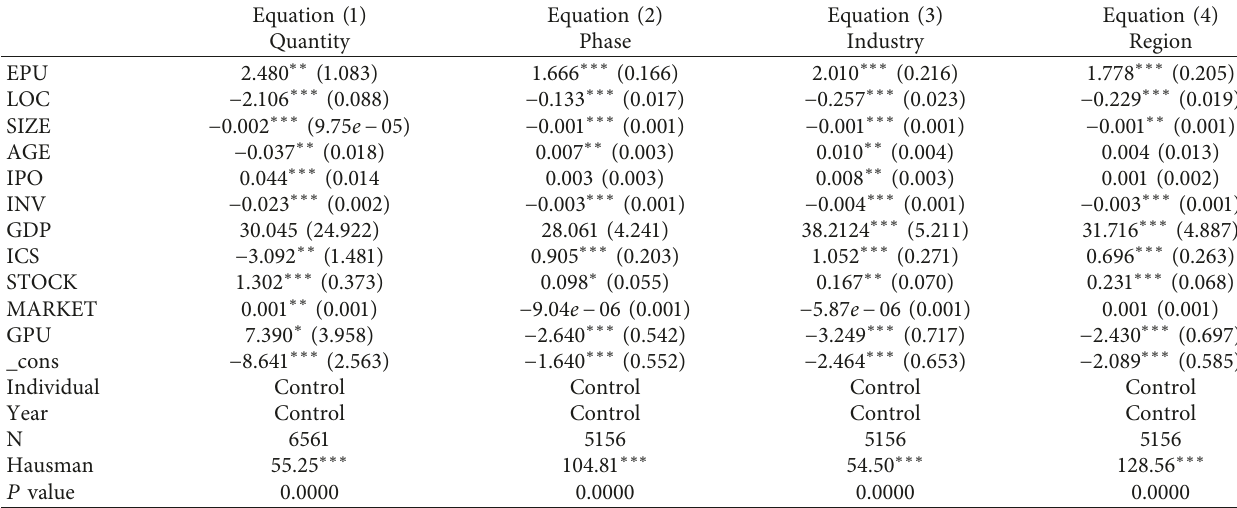
Table 3: Estimation results of benchmark